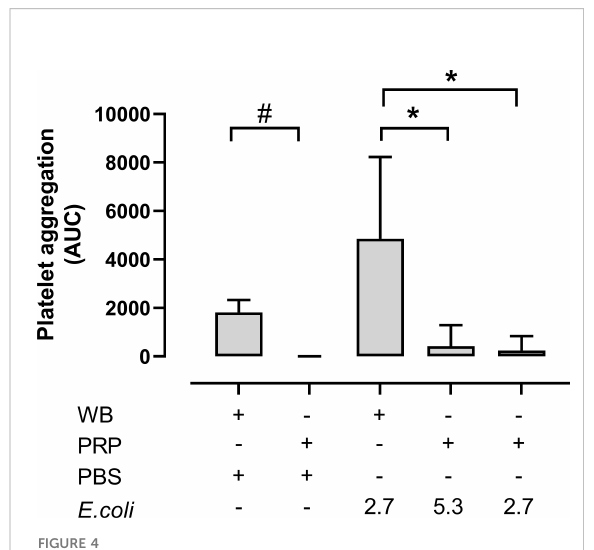
FIGURE 4 The platelet aggregation was performed in both hirudin whole blood (WB) and hirudin platelet-rich plasma (PRP). The samples were analyzed with phosphate-buffered saline (PBS) or Escherichia coli ( E. coli 2.7 x 10 9 /mL or 5.3 x 10 9/ mL) on Multiplate ® impedance aggregometry (n = 6). Results are given as the area under the curve (AUC), using mean ± standard deviation. #; p < 0.05 analyzed using a Wilcoxon test between the whole blood samples and PRP without E. coli , *; p < 0.05 analyzed using a Friedman test and Dunn ’ s multiple comparisons test, comparing E. coli -activated whole blood samples with E. coli -activated